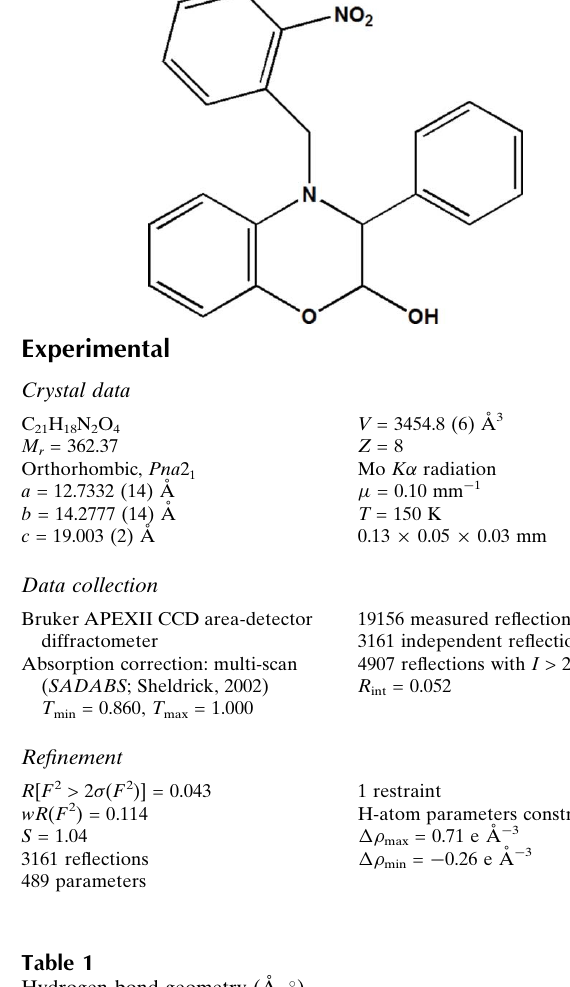
19156 measured reflections 3161 independent reflections